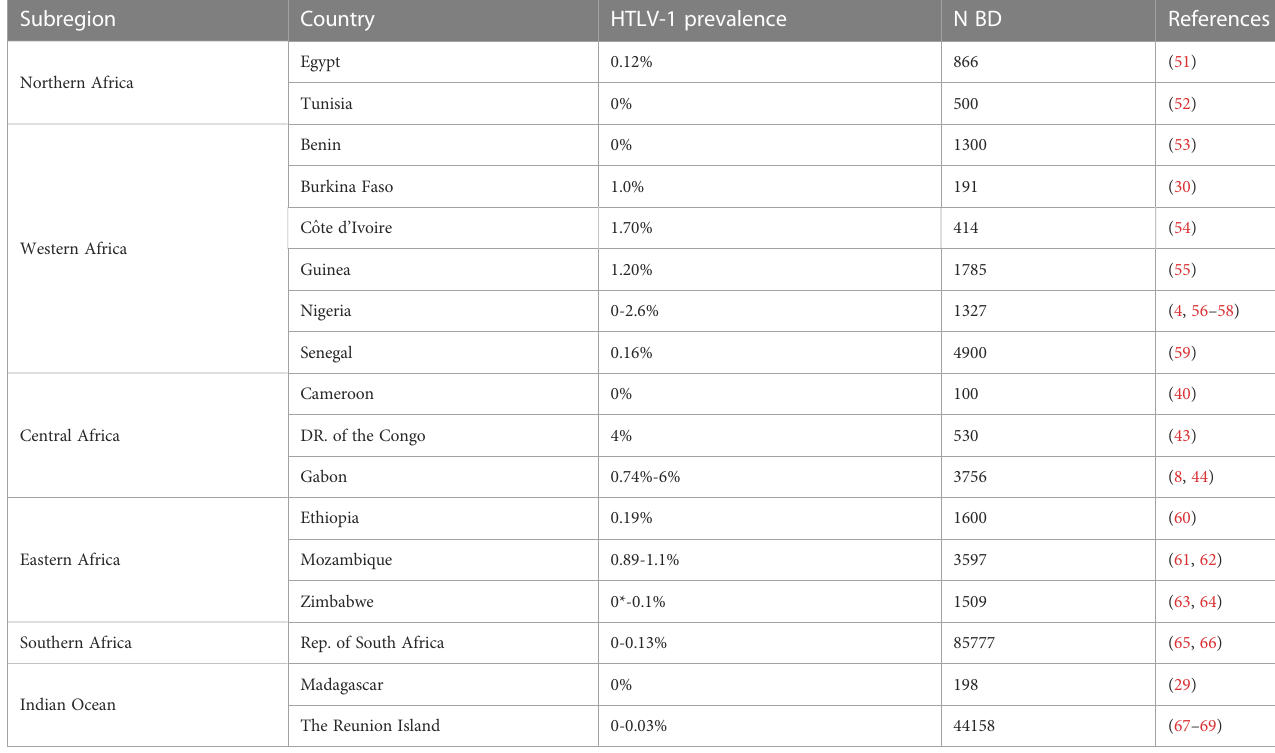
TABLE 2 HTLV-1 prevalence among African blood